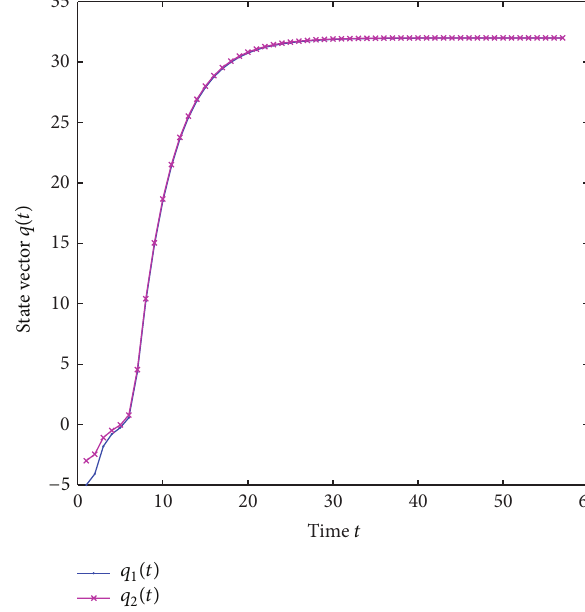
Figure 2: The state vector of system (25) with 𝑞 0 = [−5,−3] 𝑇 ∉ 𝑋 .